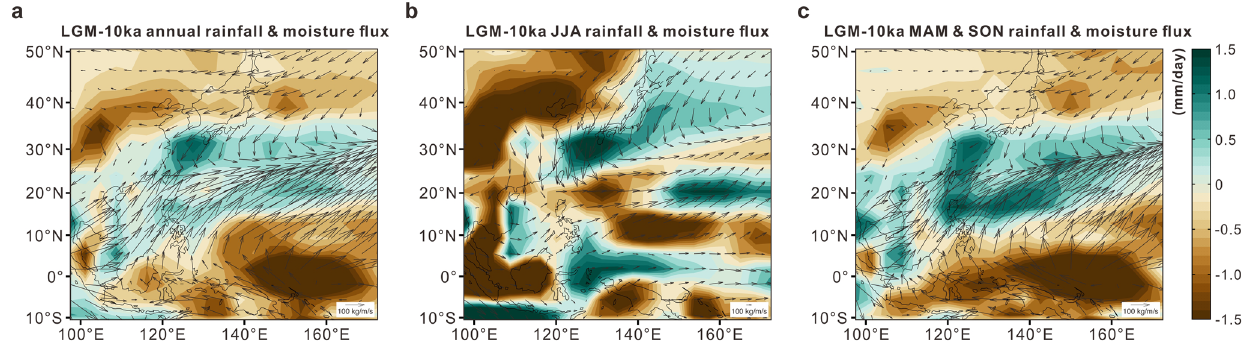
Fig. 5 Full forcing simulation of rainfall and moisture fl ux (arrows, kg/m/s) differences between LGM and 10 ka. a annual, b JJA, c MAM